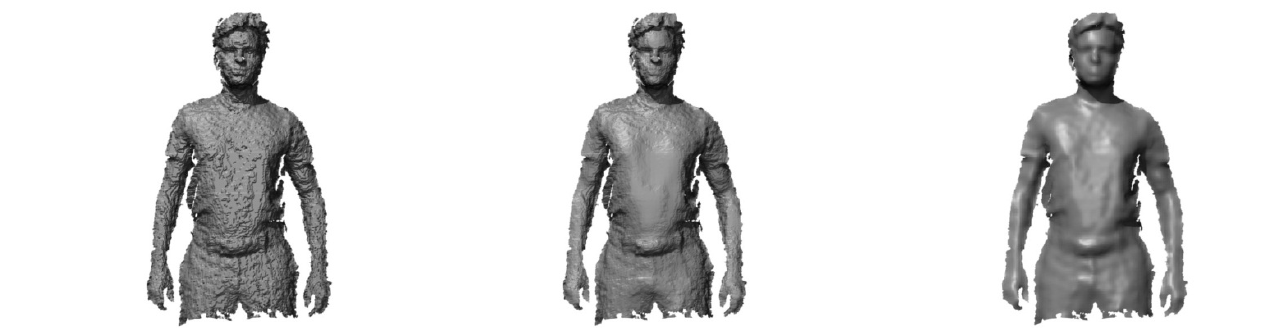
Figure 8. A mesh of the original unfiltered point cloud shows the noise of the sensor (left). Applying a bilateral filter can produce visually fair surfaces at varying smoothness levels, depending whether modest (middle) or strong (right) filter parameters are chosen.